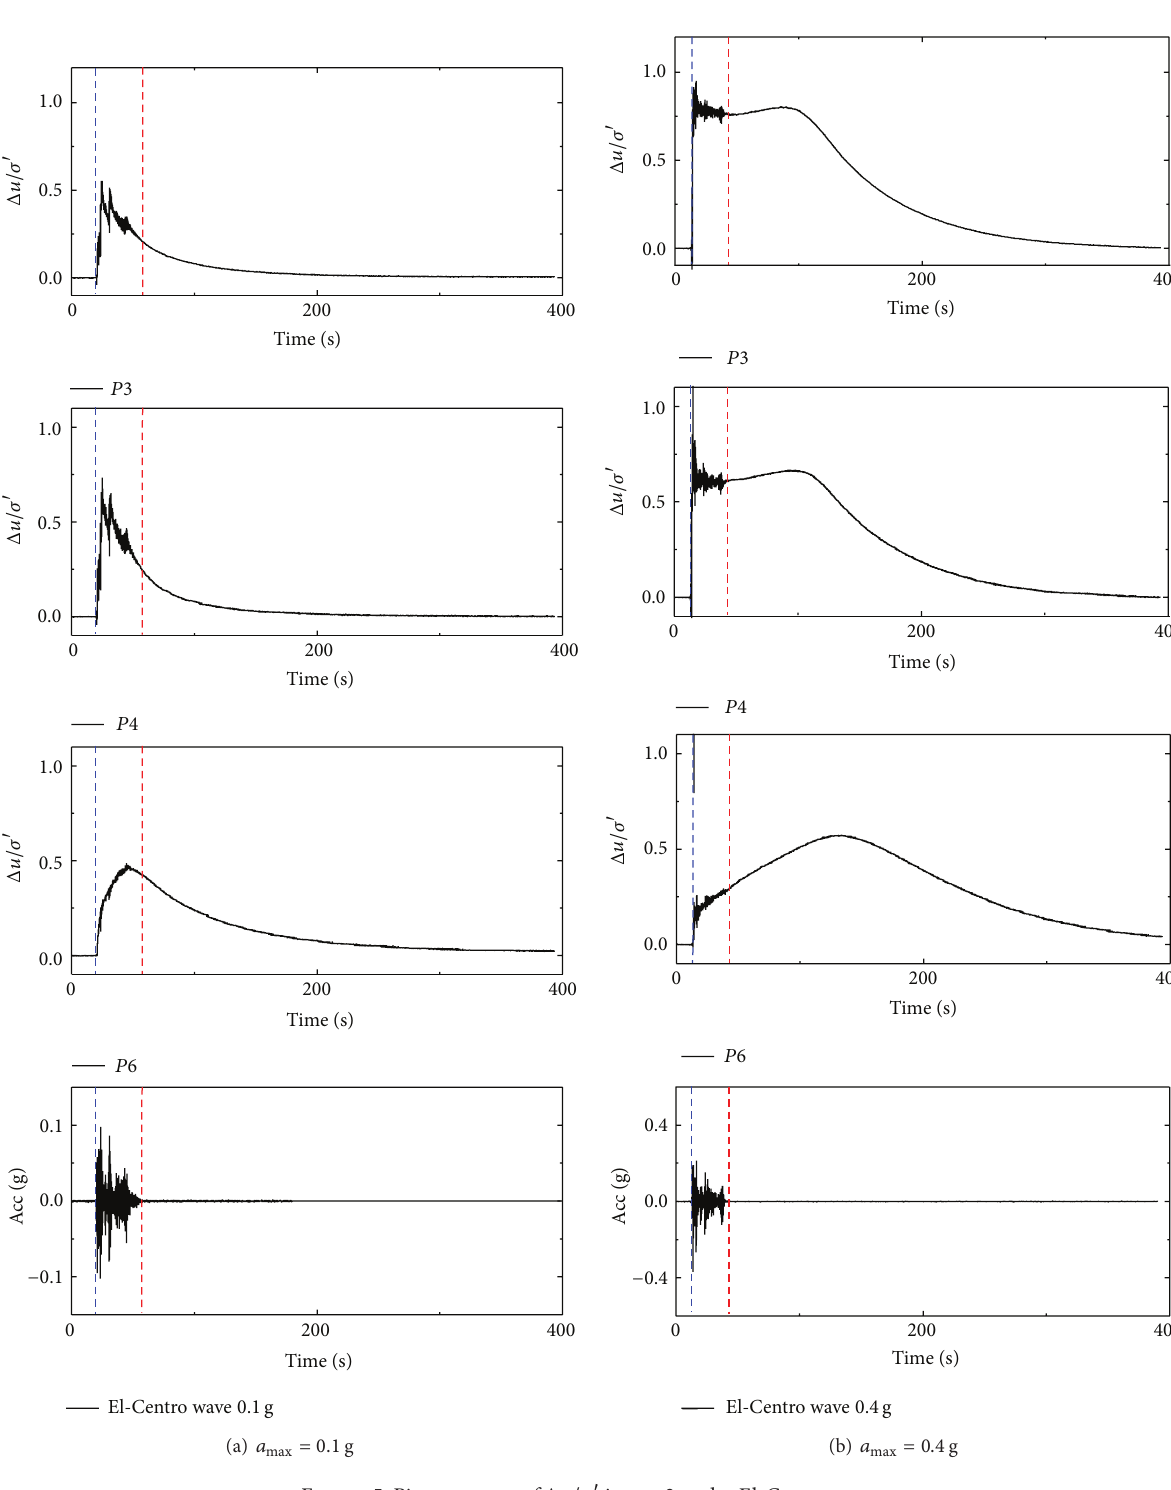
Figure 5: Pipe response of Δ𝑢/𝜎 󸀠 in test 2 under El-Centro